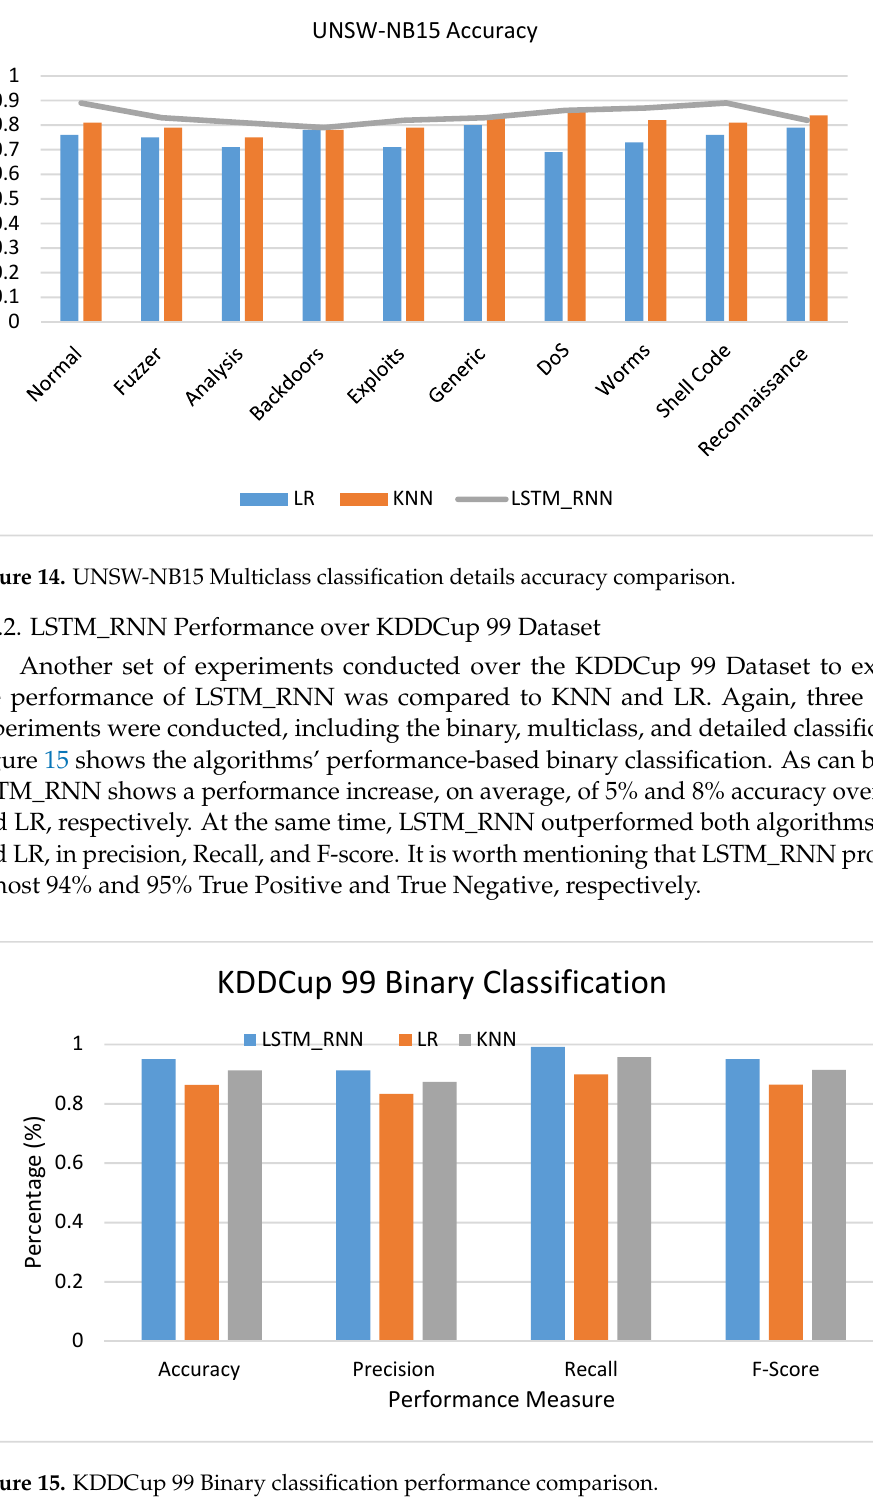
Figure 16. KDDCup 99 multiclass classification performance comparison.